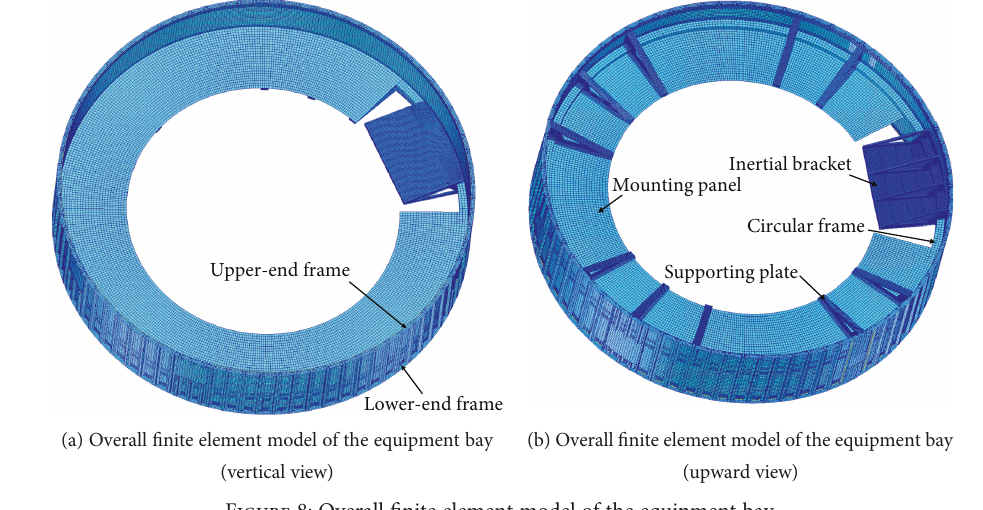
Figure 8: Overall fi nite element model of the equipment bay. Table 1: Material characteristics.